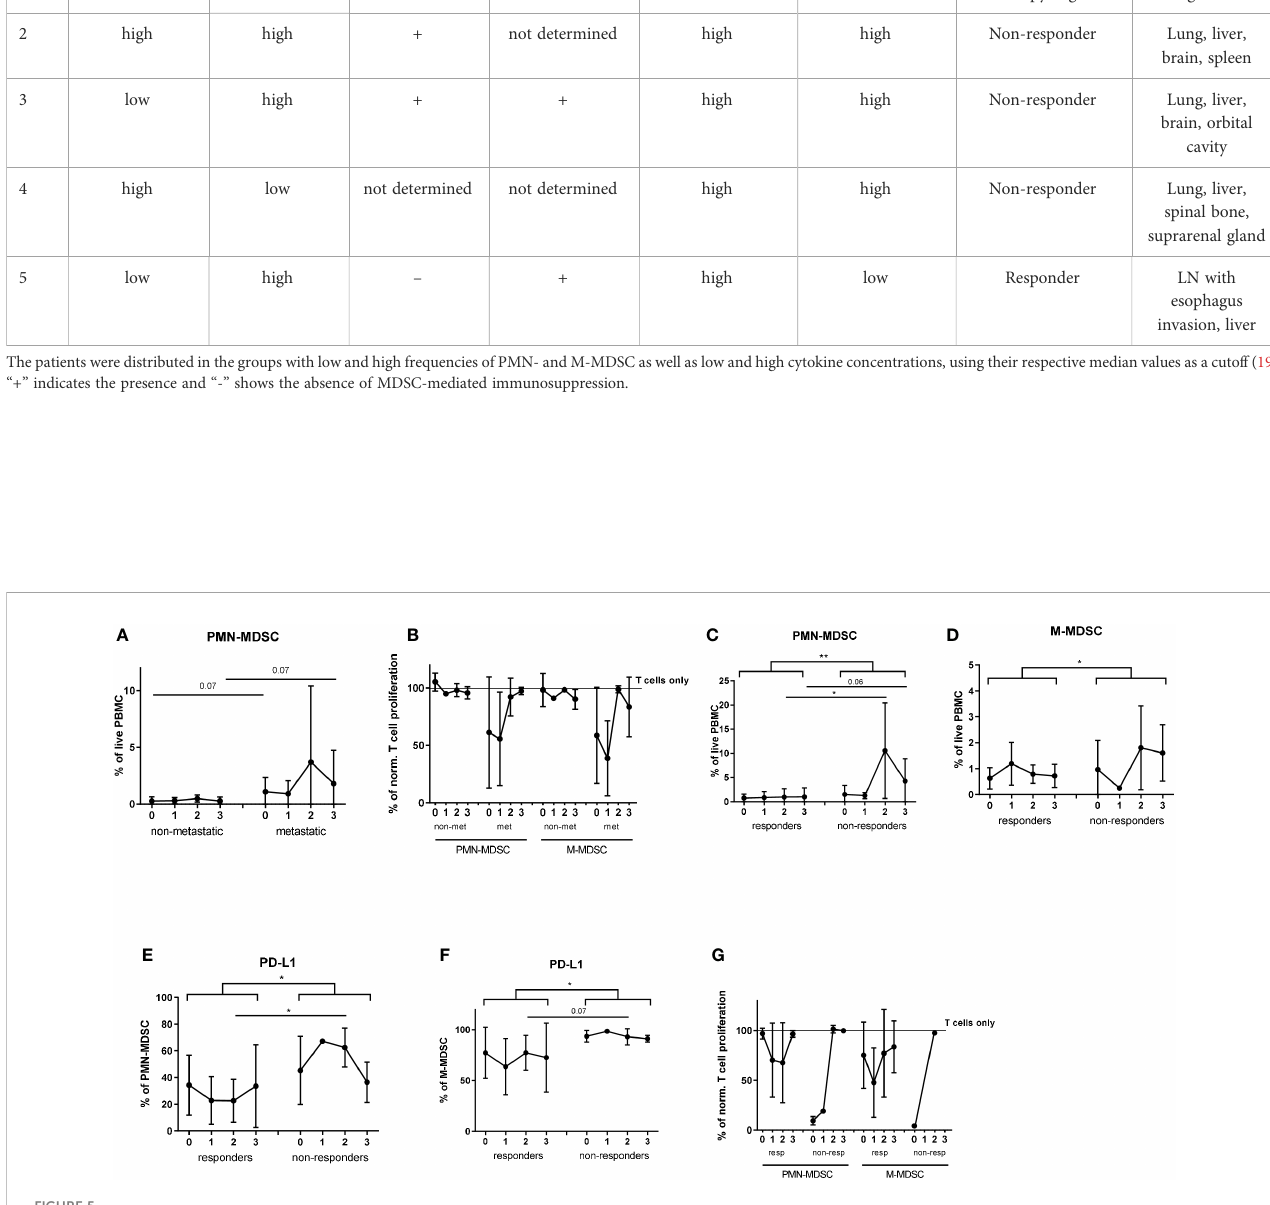
FIGURE 5 Analysis of MDSC in melanoma patients during the ICI therapy. PBMC were isolated from metastatic (n=16) and non-metastatic (n=5) patients before each ICI application (point 0 - prior the treatment; point 1 - after the fi rst infusion; point 2 - after the second infusion; point 3 - after the third infusion) and assessed by fl ow cytometry. (A) Levels of circulating PMN-MDSC in metastatic and non-metastatic patients are expressed as the percentage within live PBMC. (B) Immunosuppressive capacity of PMN- and M-MDSC was determined upon the co-culture with activated CD3 T cells labeled with CP- Dye405. Cumulative data for T cell proliferation are shown as the percentage of divided T cells normalized to the respective control of stimulated T cells alone (n=5-16). Levels of circulating PMN- (C) and M-MDSC (D) in metastatic patients, responding (n=12) and non-responding (n=4) to the ICI therapy are expressed as the percentage of corresponding subsets among live PBMC. PD-L1 expression on PMN- (E) and M-MDSC (F) in responders (n=12) and non-responders (n=4) is presented as the percentage of PD-L1 + cells among the respective MDSC subset. (G) Immunosuppressive activity of PMN- and M-MDSC was measured at different time points during the ICI therapy upon the co-culture with activated CD3 T cells labeled with CP-Dye405. Cumulative data for T cell proliferation are shown as the percentage of divided T cells normalized to the respective control of stimulated T cells alone (n=1-10). * P < 0.05, ** P <